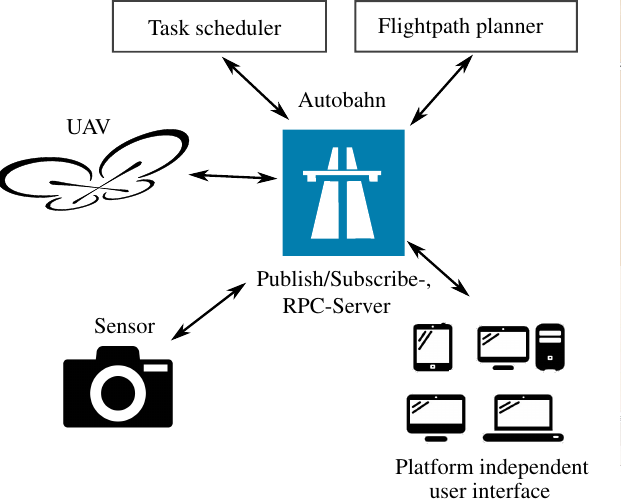
Figure 1: Software Architecture